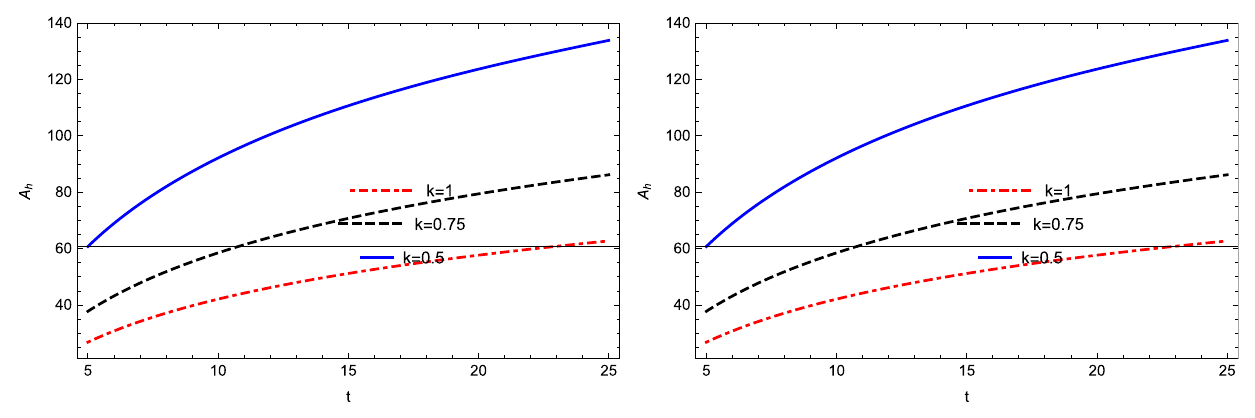
Fig. 33 Plot of A h verses t for n = − 2 . 8 and n = − 3 . 8 for Bianchi type-VI model